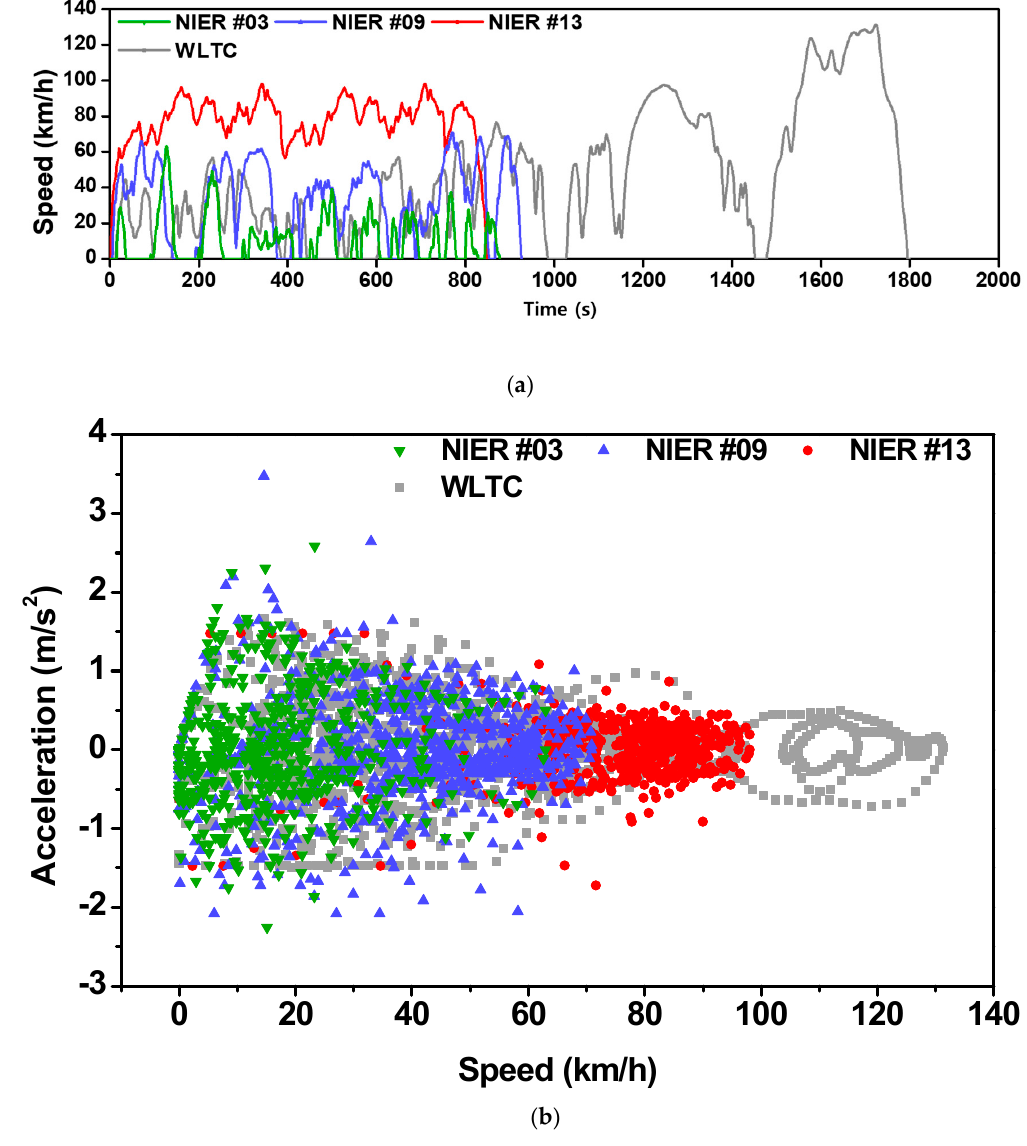
Table 3. Detailed information of test modes.